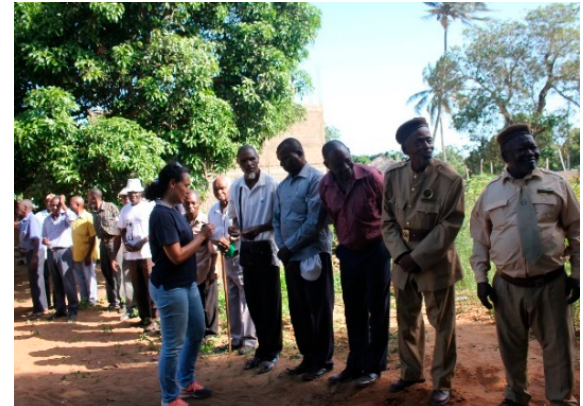
Figure 3. Meeting the local community council—Chizavane cluster.